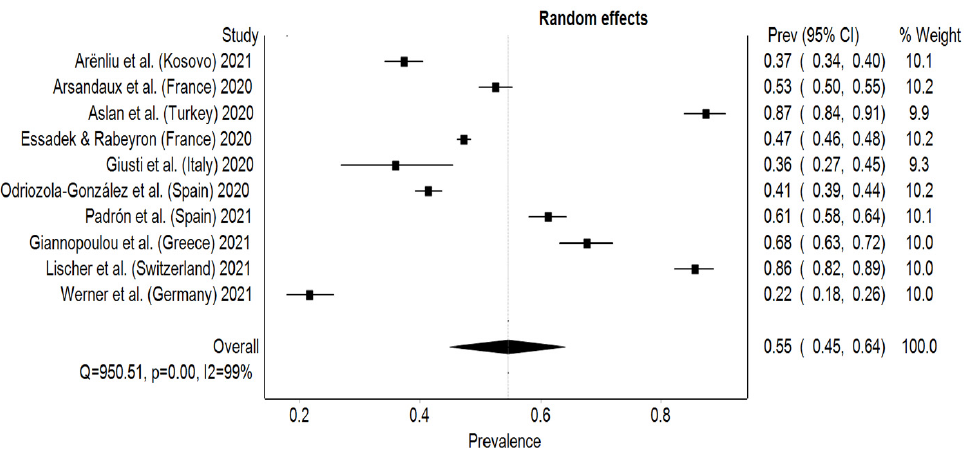
Figure 2. Forest plot of studies and their prevalence rates on Figure 2 . Forest plot of studies and their prevalence rates on anxiety .